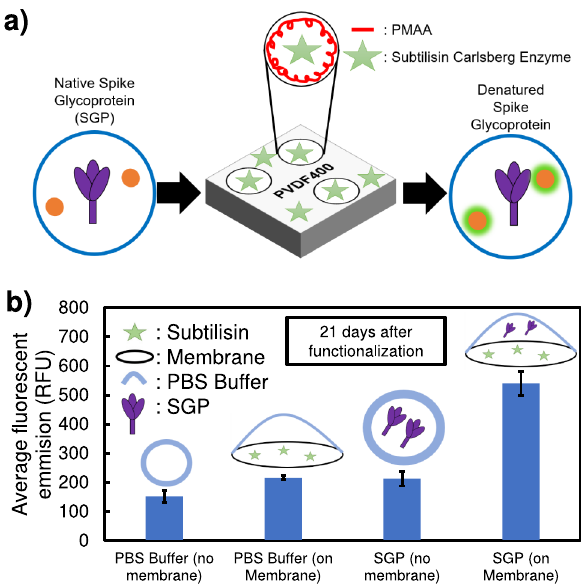
fi ed using Sypro Orange. a Schematic of Sypro-Orange protein denaturation identi fi cation method. b Average fl uorescent emission (RFU) of SGP before and after 30-s exposure to Subtilisin-functionalized (batch) PMAA-PVDF membrane in the presence of hydrophobic-binding fl uorescent dye, Sypro Orange. This membrane was functionalized using convective mode and was left in ambient conditions for 21 days after enzyme functionalization before experiment . Analyzed using Synergy H1 Hydrid Reader. 0.3 mg/mL of S-Protein and 50x Sypro Orange was utilized. Minimum hydration of membrane with 1.35 μ l of solution per cm 2 of membrane surface during denaturation process (about 0.02 % water content). Reactions were at pH of 7.8 and 23 °C. Error bars represent the standard deviation of 3 different measurements taken on triplicate